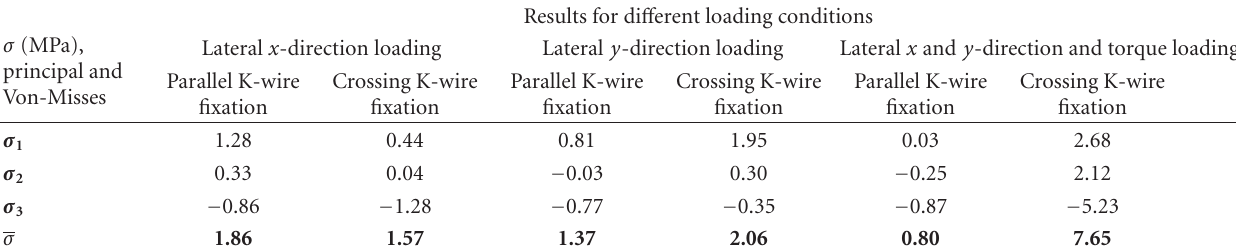
Table 4: Summery of FE results for bottom crack